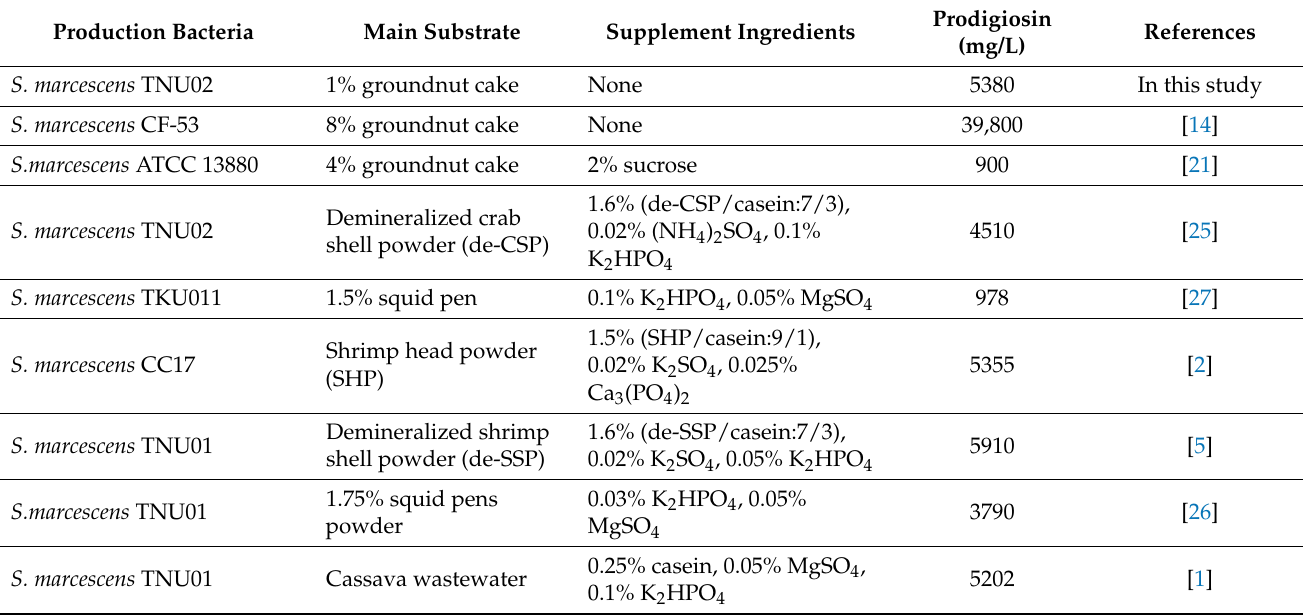
Table 3. The medium formulation of several reports using by-product as the main